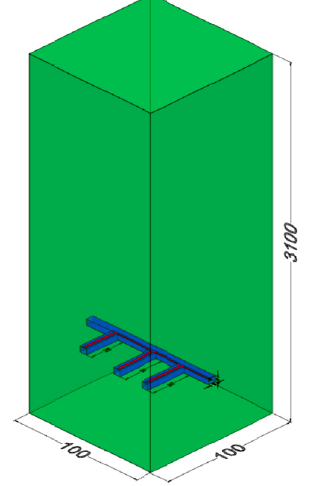
Figure 1. Rock total control volumen.